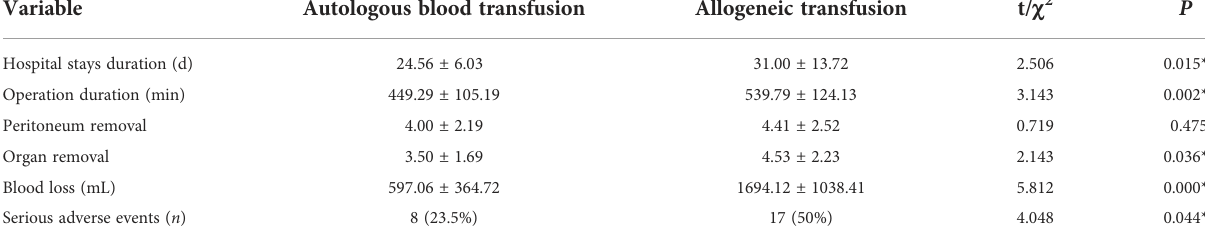
TABLE 5 Perioperative data of patients in the two groups.